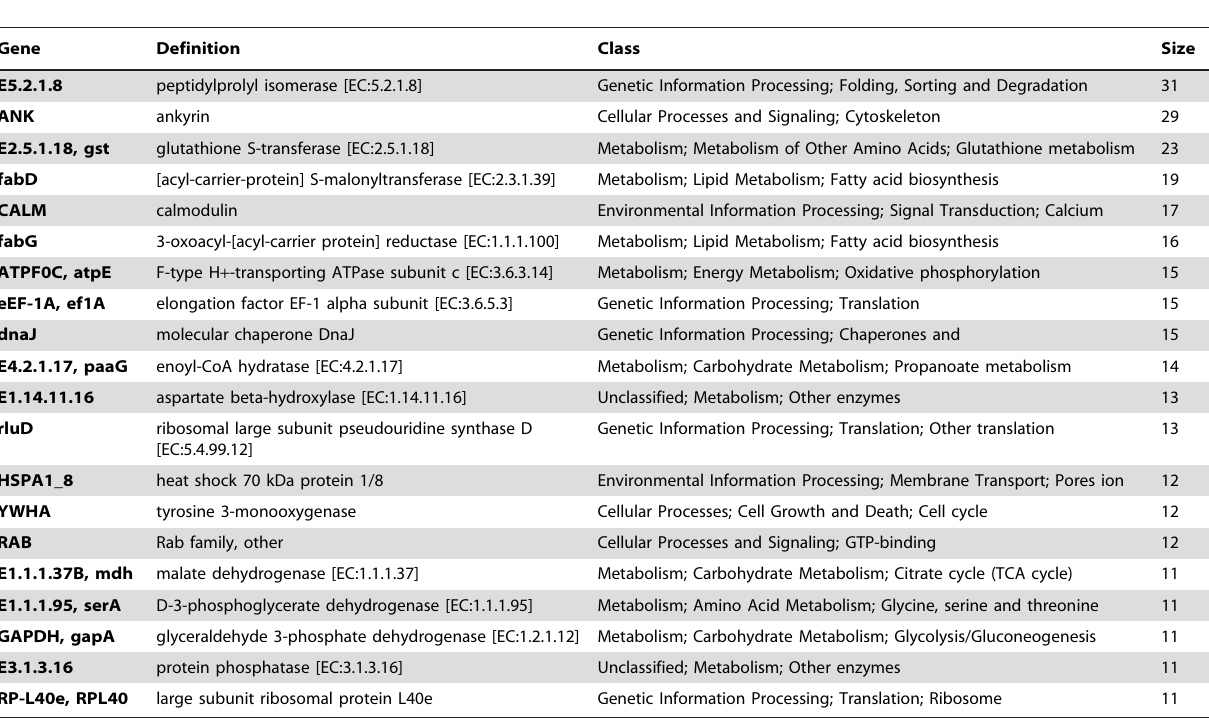
Table 2. Gene families identified using KEGG orthology that have sizes . 10